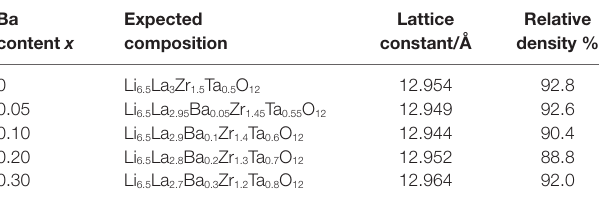
TaBle 1 | expected compositions, lattice constants, relative densities of sintered llZT and llBZT with different Ba contents x .